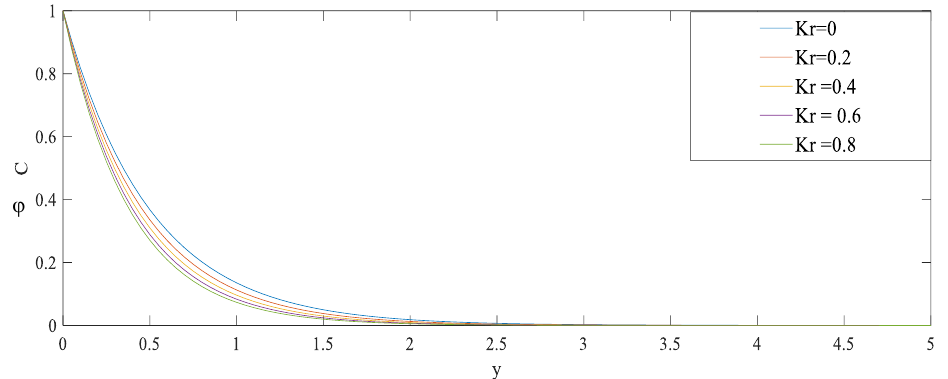
Figure 9: Concentration profile against displacement variable y for Nr=0.1, Pr=5, M=2, b=0.5, Sc=2, Du=0.5, Q=0.2, Q1=0.3, e=0.001, eta(η) =0.2, n=0.1, Kp=0.3, Gr=5, n 1 =0.2, h=0.4, Gm=0.3 at